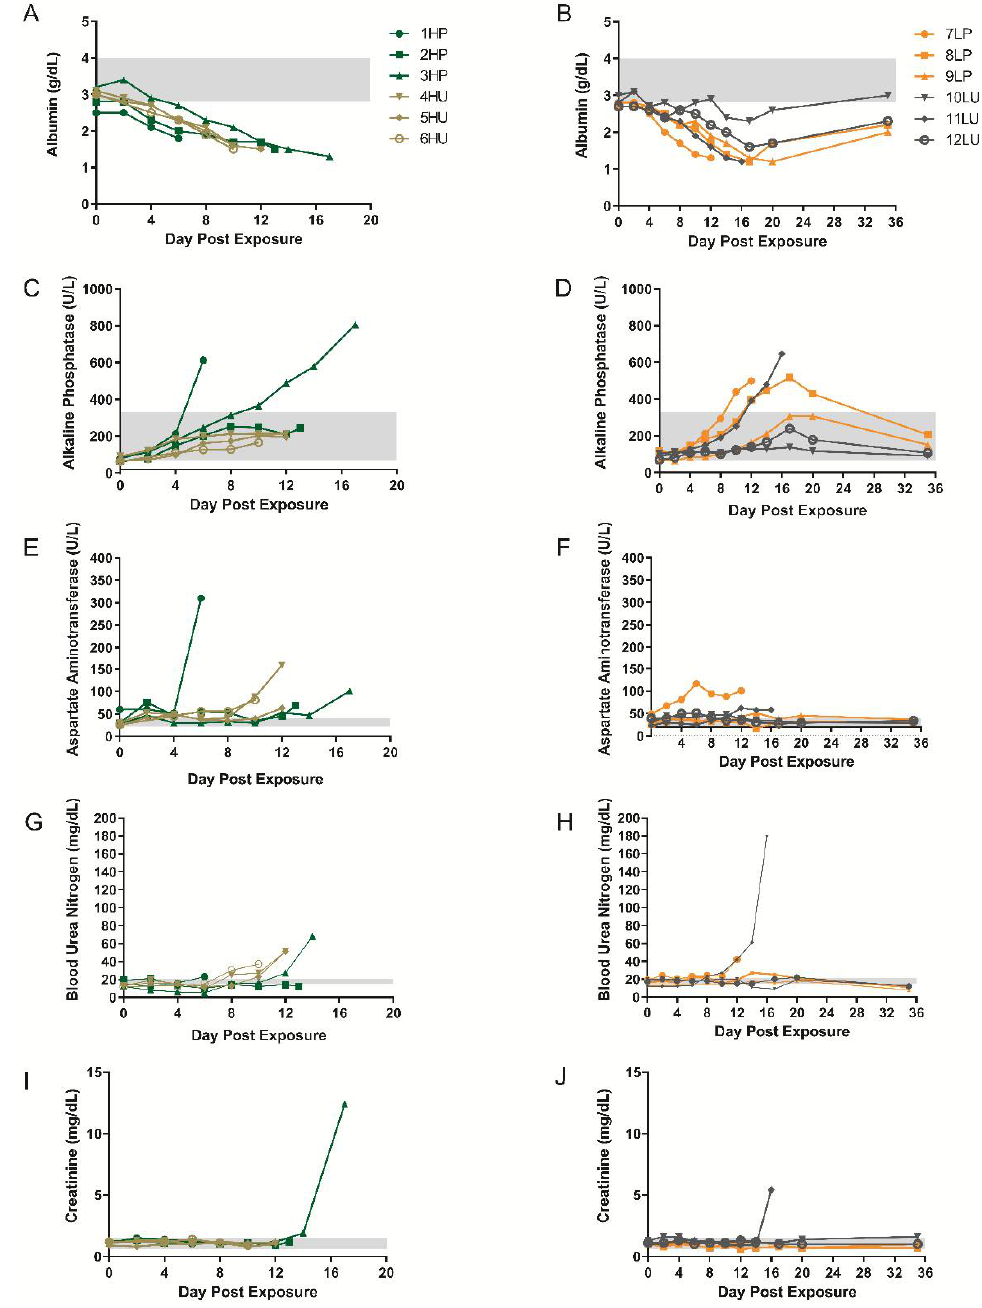
Figure 6. Blood chemistry analysis from cynomolgus macaques exposed to purified or unpurified preparations of monkeypox virus. Blood was collected into serum separating tubes (SST) and the resulting sera were analyzed using General Chemistry 12 discs using an Abaxis Piccolo. Analytes include albumin ( A , B ), alkaline phosphatase ( C , D ), aspartate aminotransferase ( E , F ), blood urea nitrogen ( G , H ), and creatinine, ( I , J ). HP, high dose purified; low dose purified, LP; high dose crude, HU; low dose crude, LU. Normal ranges (grey boxes) were previously reported [21], with the exception of ( E , F ).